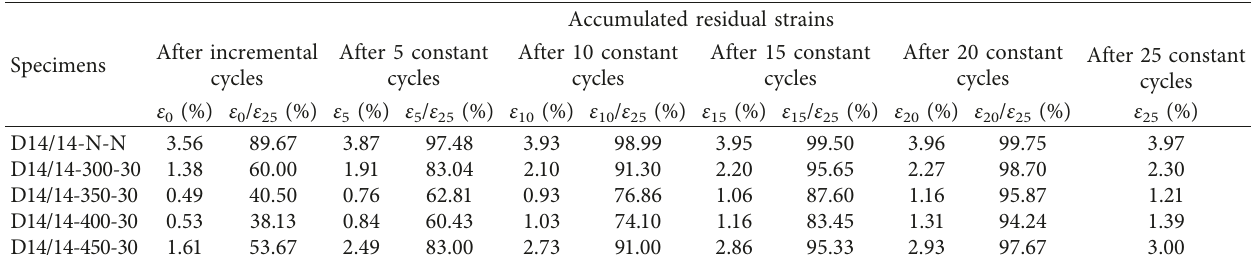
Figure 6: Stress-strain responses under loading protocol LP (I-0.03 and II-0.03-25). Table 2: Accumulated residual strains at typical loading